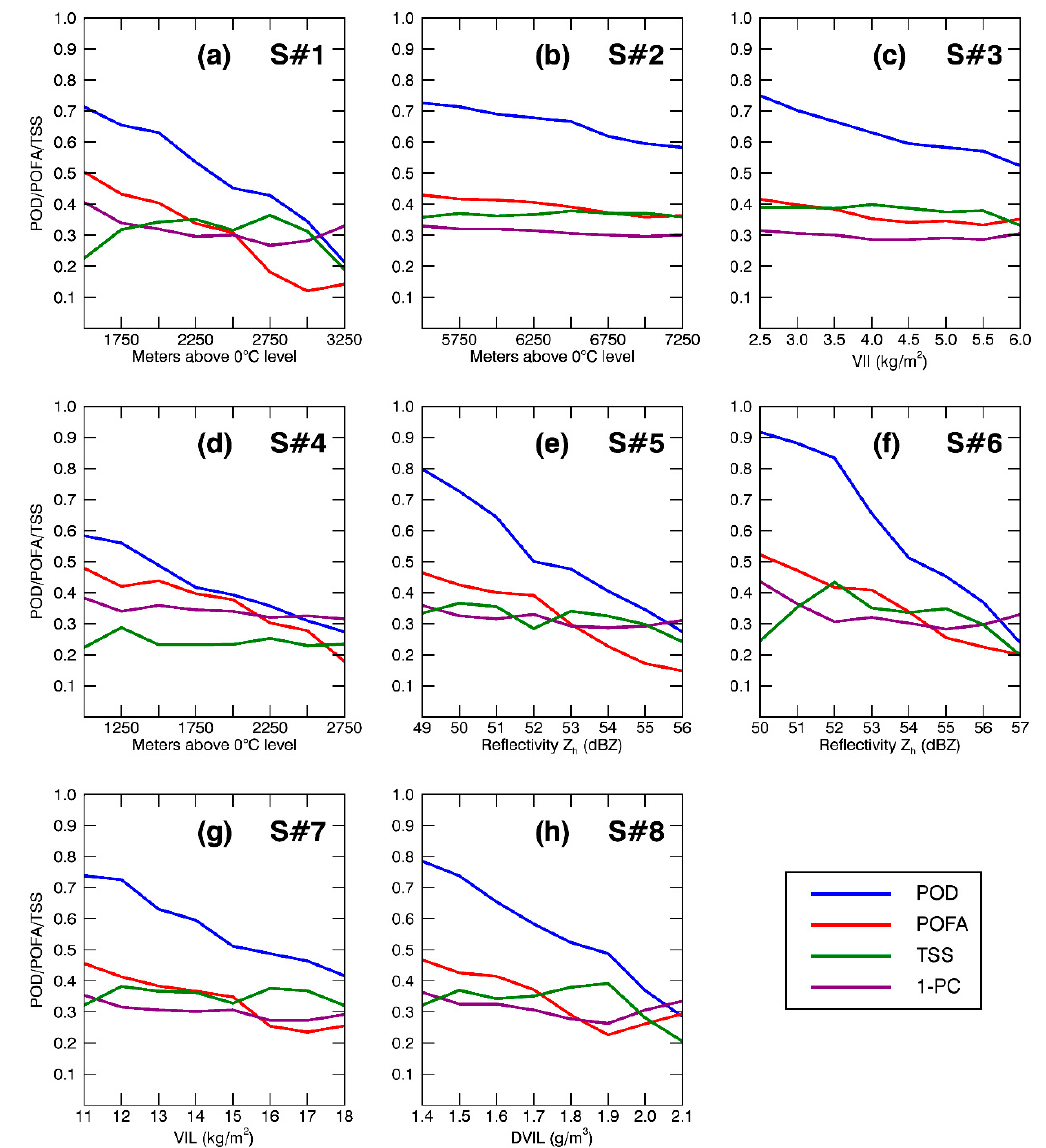
Figure 5. POD, POFA, TSS, and 1-PC for the single signatures prediction for different thresholds applied. The optimal value for POD and TSS is 1, and for POFA and 1-PC is 0. Radar signatures are: ( a ) Z dr column maximum height; ( b ) Precipitation ice signature maximum height; ( c ) VII; ( d ) Height of peak Z h above the 0°C isotherm level; ( e ) Peak Z h above the 0°C isotherm level; ( f ) Peak Z h within the storm; ( g ) VIL; ( h ) DVIL.